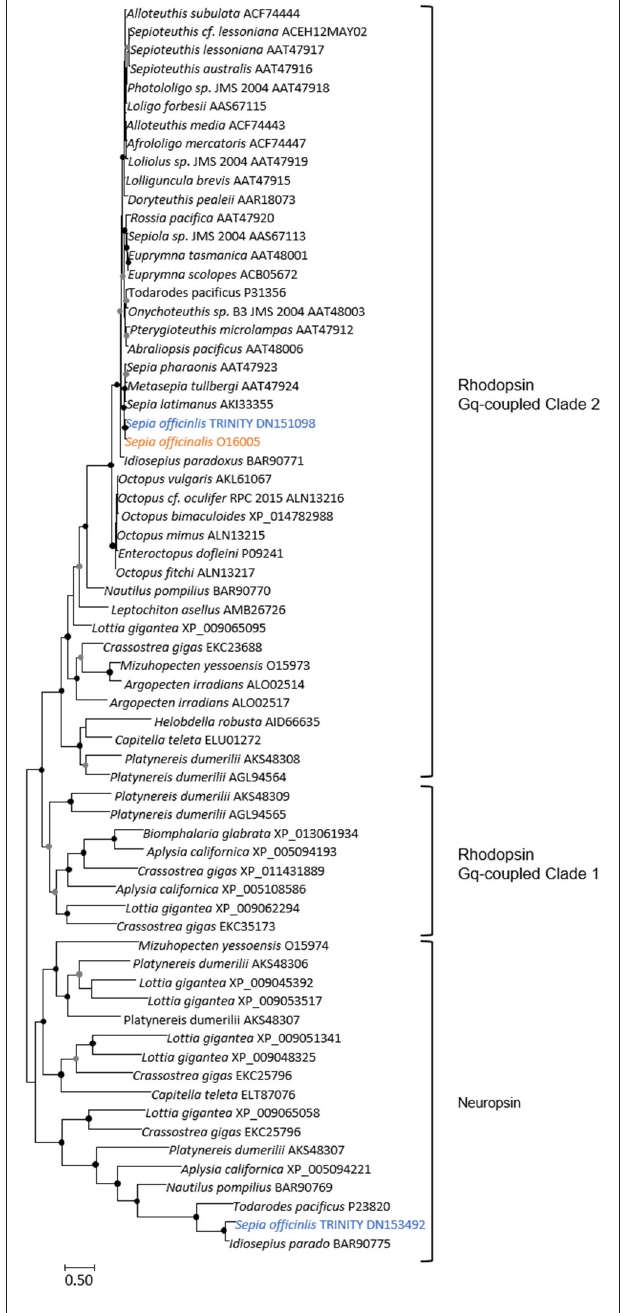
FIGURE 6 | Diversity of Lophotrochozoa opsins. This unrooted tree corresponds only to Gq-coupled/rhabdomeric opsins and to Neuropsin types. Maximum-likelihood tree based on 170 aligned amino-acids. The opsin-like protein which identical (100% conserved at the protein level, and 99% (717/718) identities at the nucleotide level); not shown) to the EST used in our study is shown in orange , and the S. officinalis contigs/genes are shown in blue. For the color code used for the bootstraps refer to Figure 3